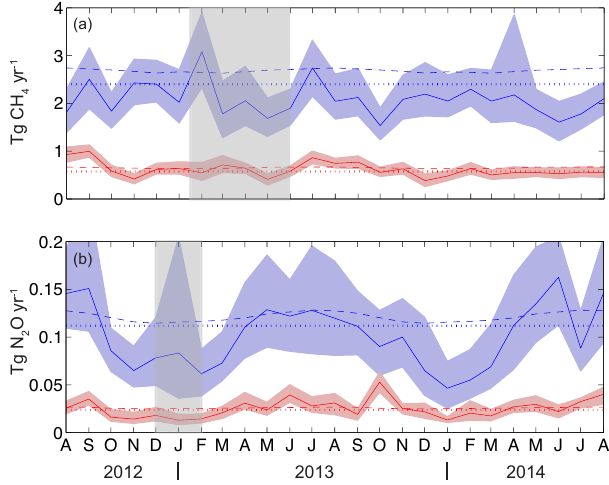
Figure 3. Median posterior (a) CH 4 and (b) N 2 O emissions in Tgyr − 1 for the UK (blue) and Ireland (red). Solid lines correspond to top-down estimates, dashed lines to the total prior emissions and dotted lines to the anthropogenic component of the prior. Shading on emissions corresponds to the 5th to 95th percentile range of the posterior distribution. The grey shading corresponds to times where data from a station were largely missing (TTA for CH 4 and RGL for N 2